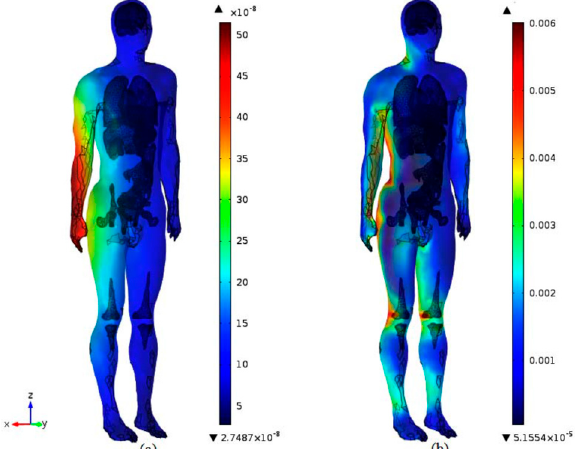
Figure 3. Distribution of induced fields in the human body, by an IPT under EV, for the configuration of horizontal, ground lying body beside the EV. ( a ) Magnitude of magnetic flux density B (T), ( b ) Magnitude of electric E-field (V/m).